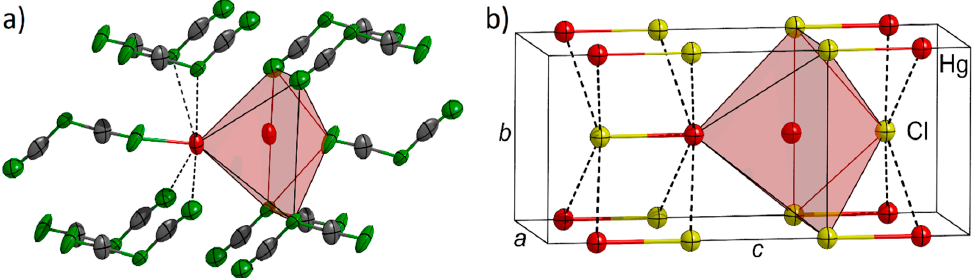
Figure 2. Comparison of the crystal structures of Hg 2 [dca] 2 and calomel, Hg 2 Cl 2 . ( a ) Coordination sphere of Hg in Hg 2 [dca] 2 . The atomic displacement ellipsoids correspond to 90% probability using the refined ADPs. ( b ) Crystal structure of Hg 2 Cl 2 [26] .